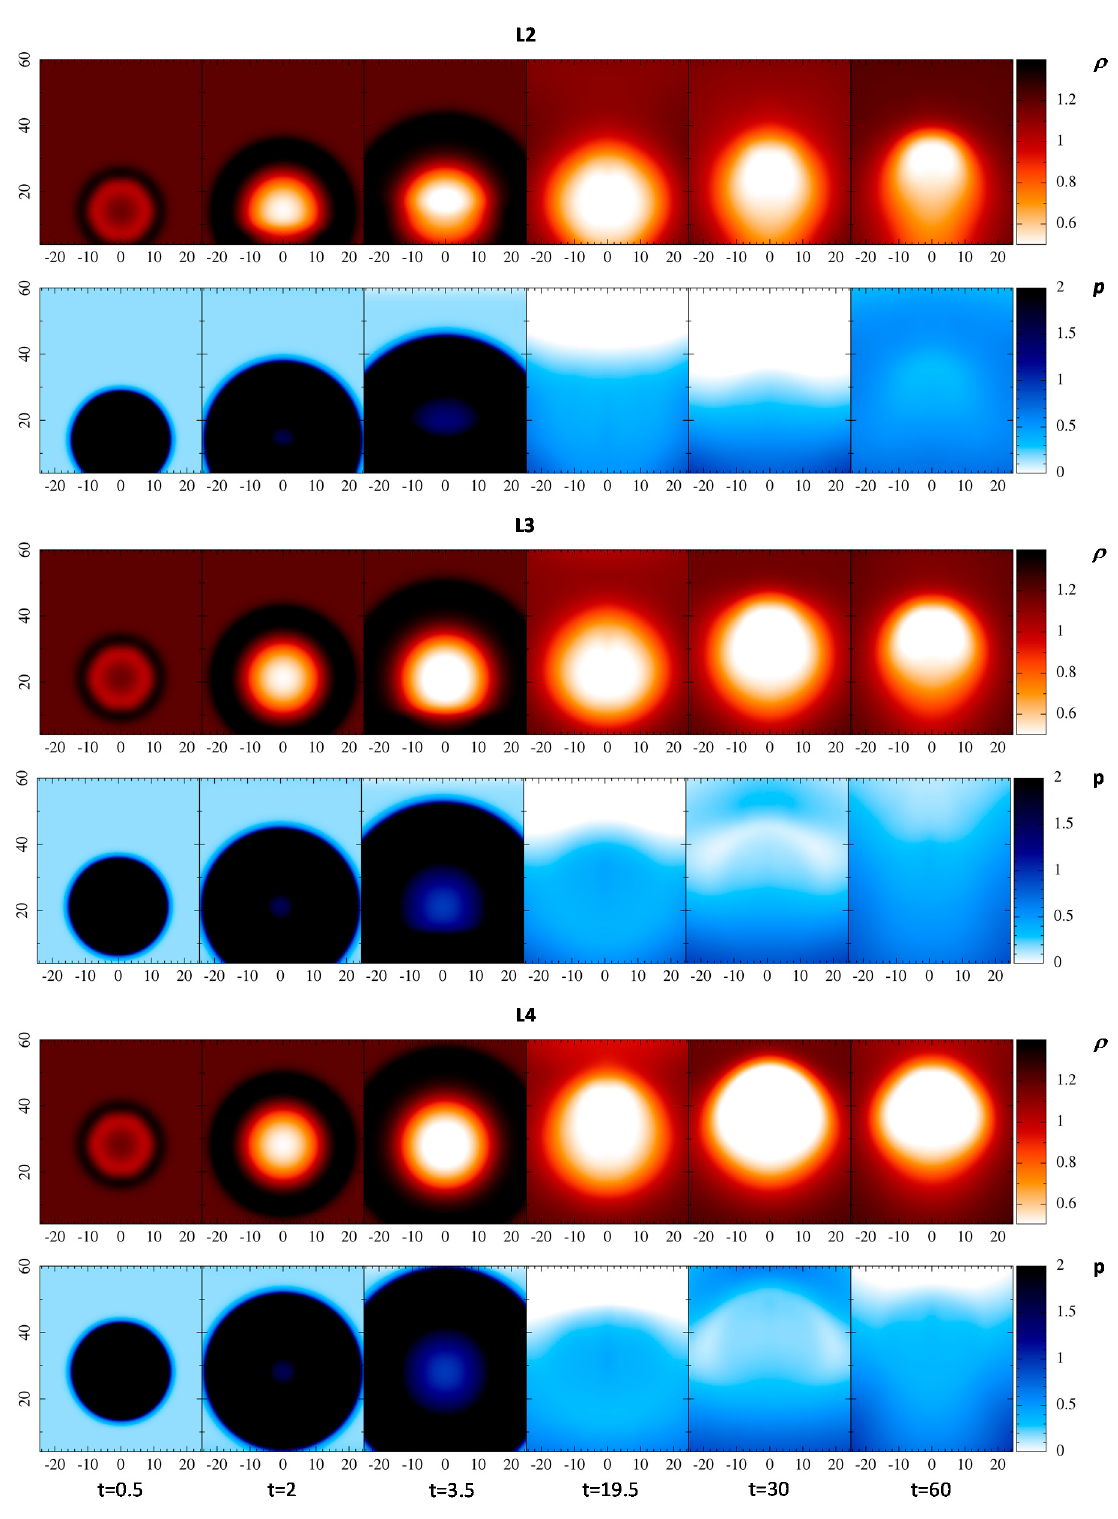
Figure 5. Density contour ( top ) and pressure contour ( below ) during bubble